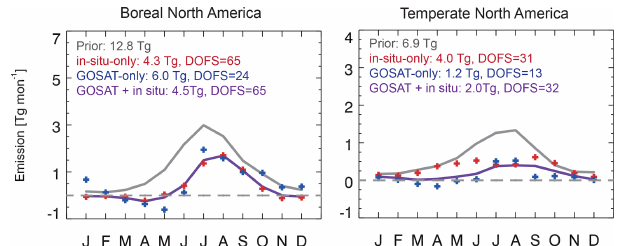
Figure 10. Wetland emissions in boreal and temperate North Amer- ica (regions 2 and 3 of Fig. 3). Prior and posterior estimates of the monthly mean wetland emissions averaged over 2010–2017 from different inversions are shown. Annual mean emissions and the de- gree of freedom for signal (DOFS) for monthly emissions in indi- vidual years are shown inset. Note the differences in scale between panels. Negative emissions are allowed statistically by the inversion but are likely not